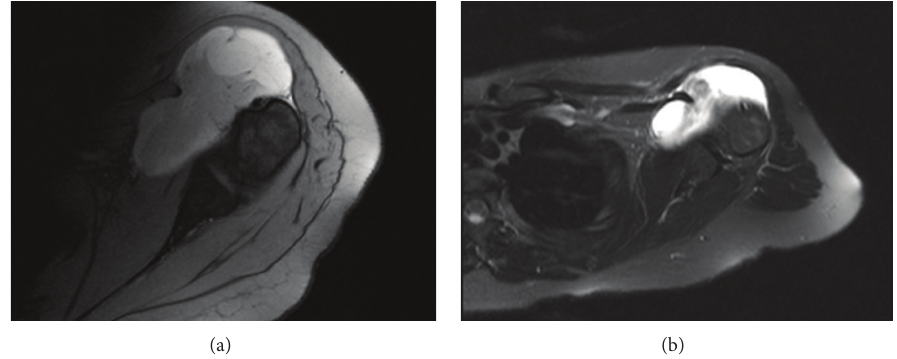
Figure 2: (a) Pre- and (b) postradiation therapy MRI of synoviosarcoma of the anterior shoulder joint.